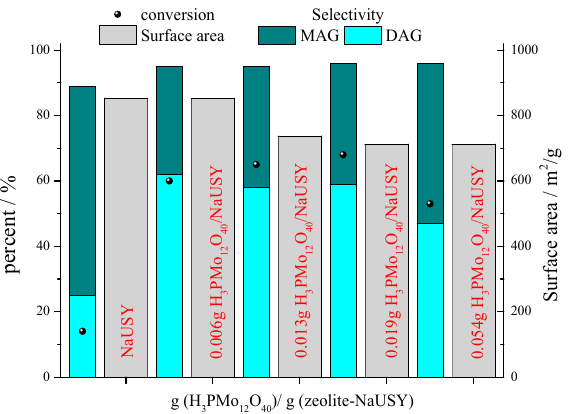
Figure 4. Surface area, conversion, and selectivity to the products of the esterification of glycerol with acetic acid over H 3 PMo 12 O 40 encaged in the NaUSY zeolite. (Adapted from ref. [47]). The reaction conversions in Figure 3; Figure 4 were achieved under different